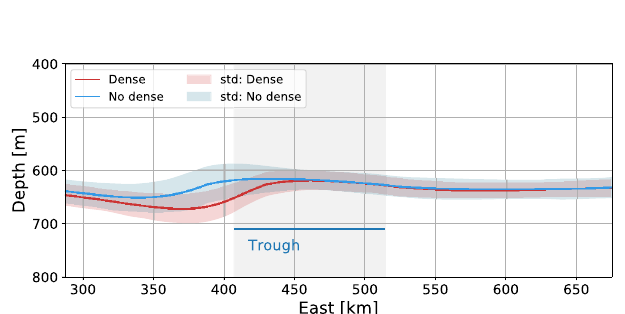
linesin b and c showthemeanisothermdepthandthestandarddeviation(vertical bars) in 250m depth bins. The mean depth from b is included in c asa dashedline for reference. Temperature pro fi les from d March and e May collected by Weddell seals in 2011 21 on the continental shelf west (red)and east (blue, dashed) of the FT. Individual pro fi les are shown in pale colors, and the mean pro fi les are highlighted. f Map showing the position of the pro fi les in a – d with dots in the corresponding colorandpro fi lesfrom e asblackdots.Isobaths[every500m] 27 areshowninblack.